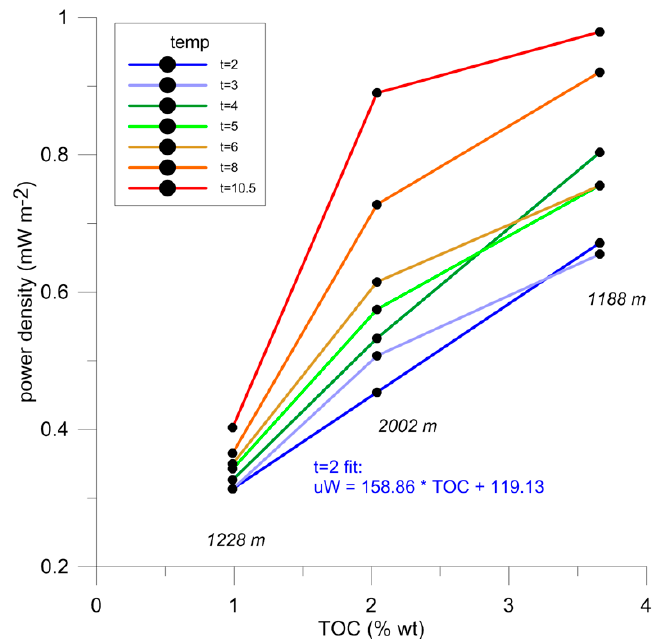
Figure 12. MFC power density versus TOC and bath temperature.